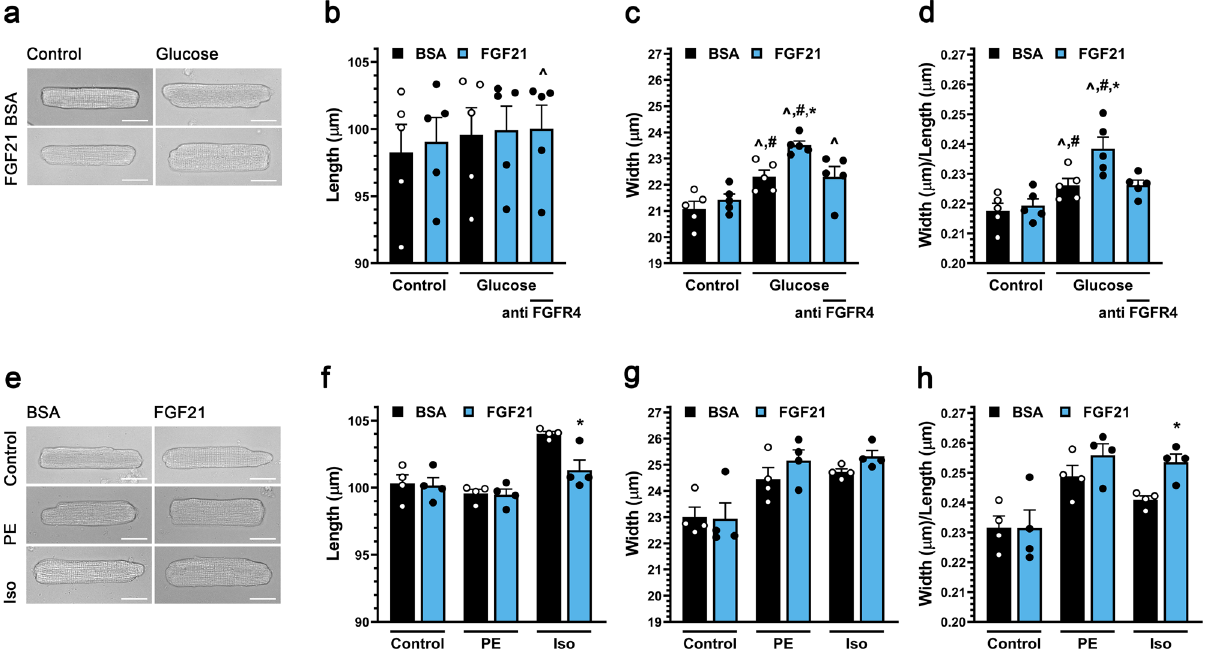
Figure 2. FGF21 induces hypertrophic growth of cultured cardiac myocytes in the presence of high glucose via FGFR4. ( a ) Transmitted light images of primary adult rat ventricular myocytes (ARVMs) treated with BSA (control), and mouse recombinant FGF21 (25 ng/ml) with or without 10 mM increased glucose (final 5.6 or 15.6 mM) for 48 h (scale bar = 25 µm), and ( b – d ) myocyte length, width, and width to length ratio. FGFR4- specific blocking antibody (anti-FGFR4; 10 mg/ml) was included as indicated. ( e ) Images of ARVMs treated with BSA (control), and FGF21 (25 ng/ml) with or without phenylephrine (PE; 20 µM) or isoproterenol (Iso; 10 µM) for 48 h (scale bar = 25 µm), and ( f – h ) myocyte length, width, and width to length ratio. Comparison between groups was performed in form of a one-way ( b – d , f – h ) ANOVA followed by post-hoc Tukey test. All values are expressed as mean ± SEM. ( b – d ) N = 5, ^ p ≤ 0.05 vs. BSA Control, # p ≤ 0.05 vs. FGF21 Control, *p ≤ 0.05 vs. Glucose Control. ( f – h ) N = 4, *p ≤ 0.05 vs. respective